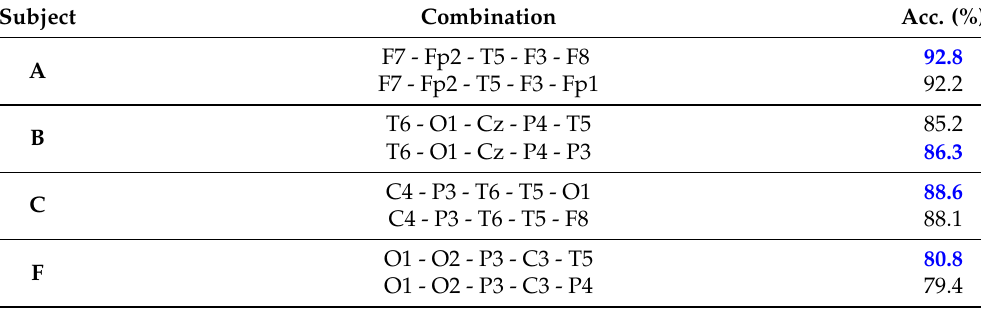
Table 8. Classification accuracies achieved for each 5-channel combination.